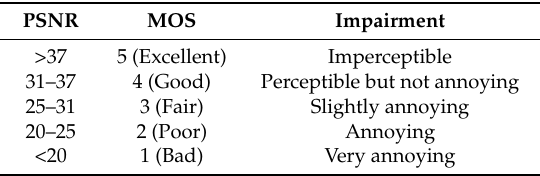
Table 7. PSNR to MOS mapping [37].